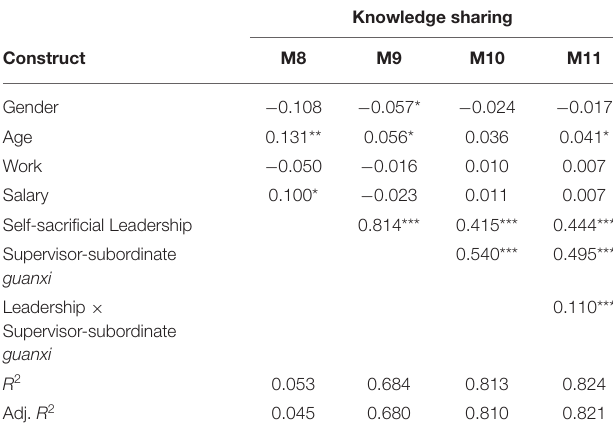
TABLE 4 | Results of moderating effect